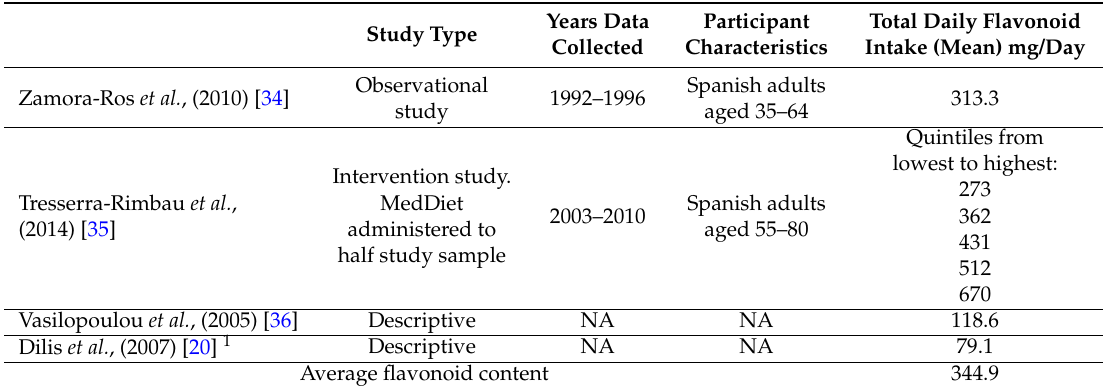
Table 6. Comparison of mean daily flavonoid intakes of the Mediterranean